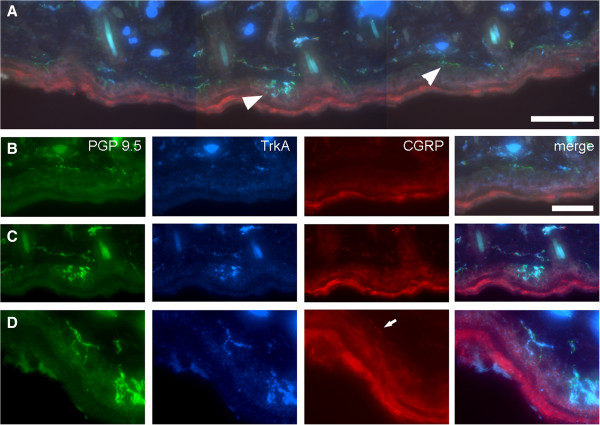
Examples of intra-epidermal nerve fibres (IENFs) in unoperated (näive) skin. The low-power image (A) shows a strip of control skin that contains several IENFs. Two marked with arrowheads are shown at higher magnification in B and C. Only one of the IENFS shown at high magnification (D) is double labelled for both TrkA (Tropomyosin-related kinase A, blue) and the neuropeptide Calcitonin gene-related peptide (CGRP, red; arrow). Scale bar = 200 μm (A), 10 μm (B, C) and 5 μm (D).